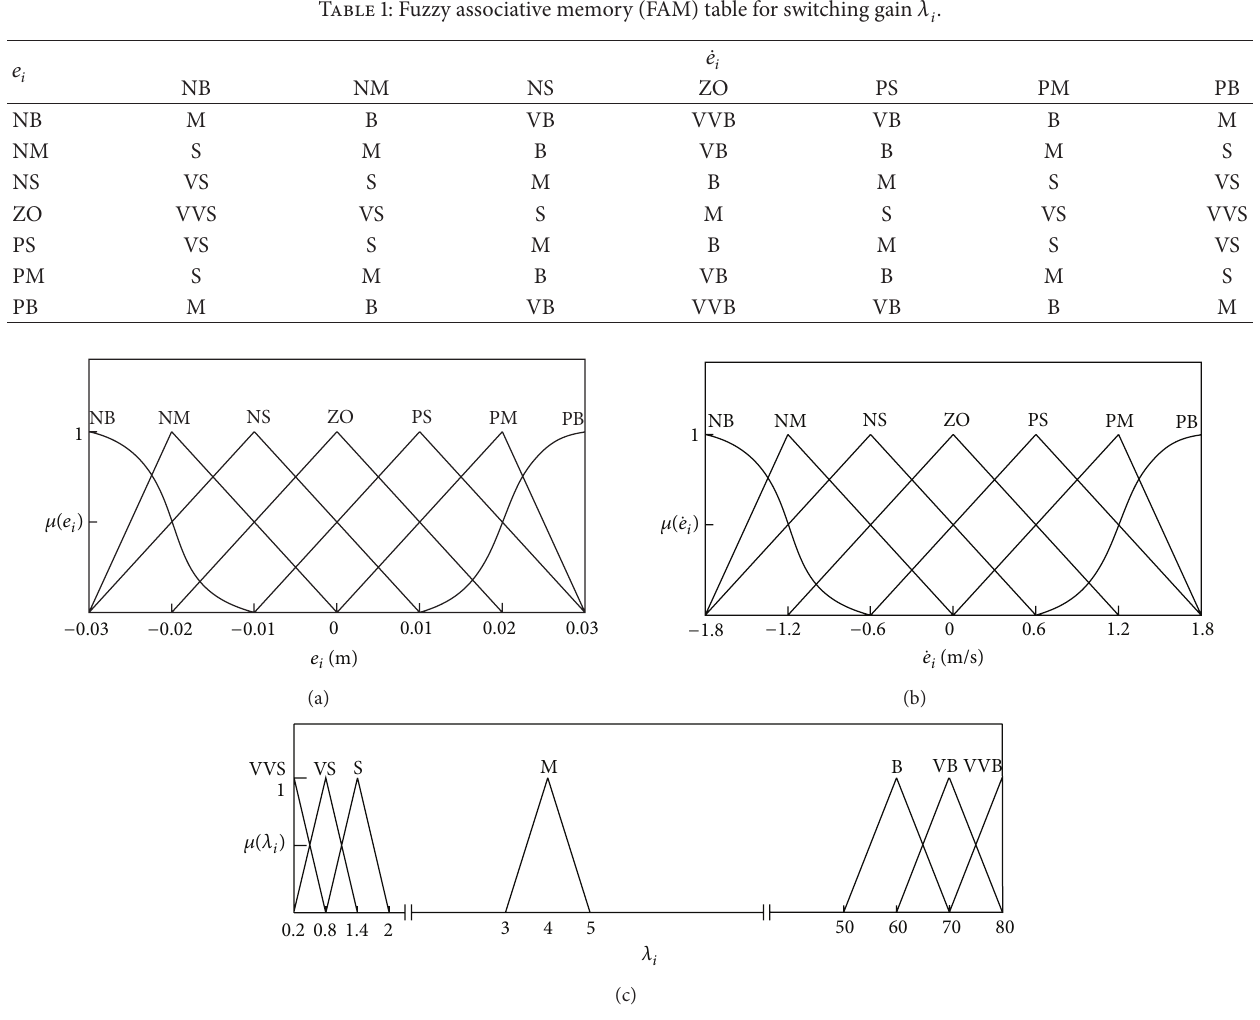
Figure 5: Membership functions (a) error, (b) derivative of error, and (c) switching